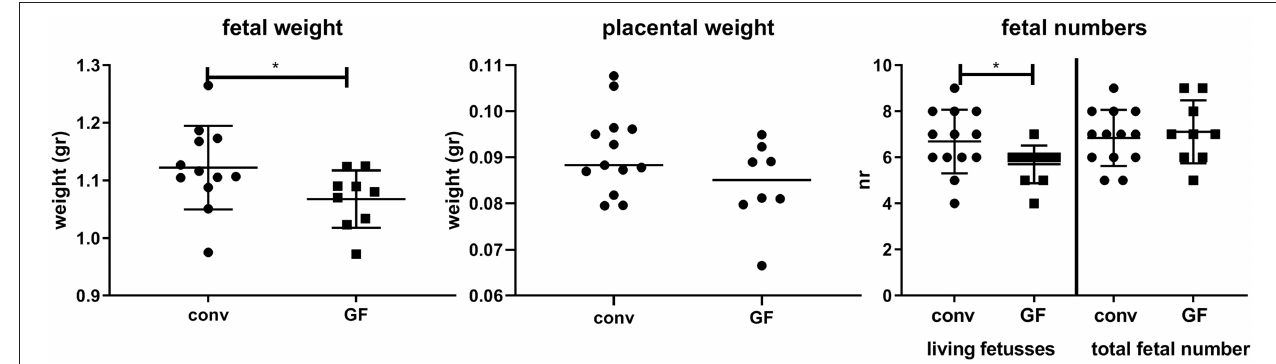
FIGURE 5 | Fetal and placental weight and fetal numbers (living fetuses and total numbers) for conventional day 18 pregnant (conv) and germfree day 18 pregnant (GF) mice. *Significantly different from conventional mice (Mann-Whitney- U -test, p < 0.05).